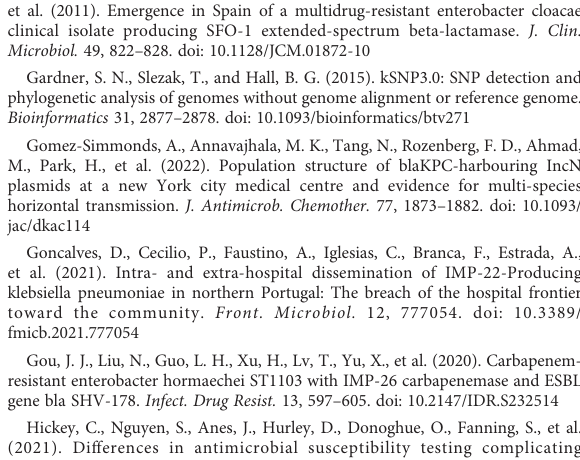
SUPPLEMENTARY FIGURE 5 Genetic context of blaIMP-4 on pYQ13422-IMP-4 and blaSFO-1 on pYQ13422-SFO-1. Genes are denoted by arrows. Genes, mobile elements, and other features are colored based on their functional classi fi cation.